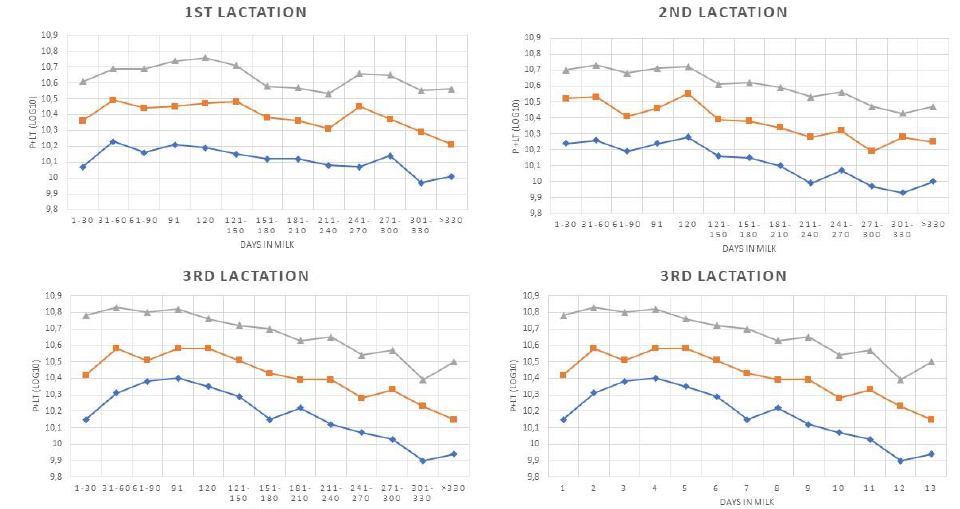
> 800,000 cells / mL. 